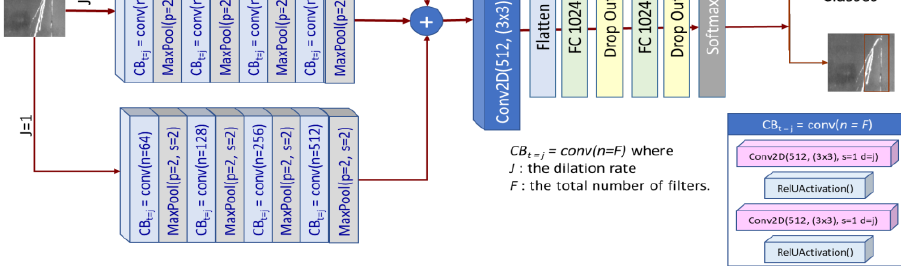
Figure 5. DSTEELNet architecture.